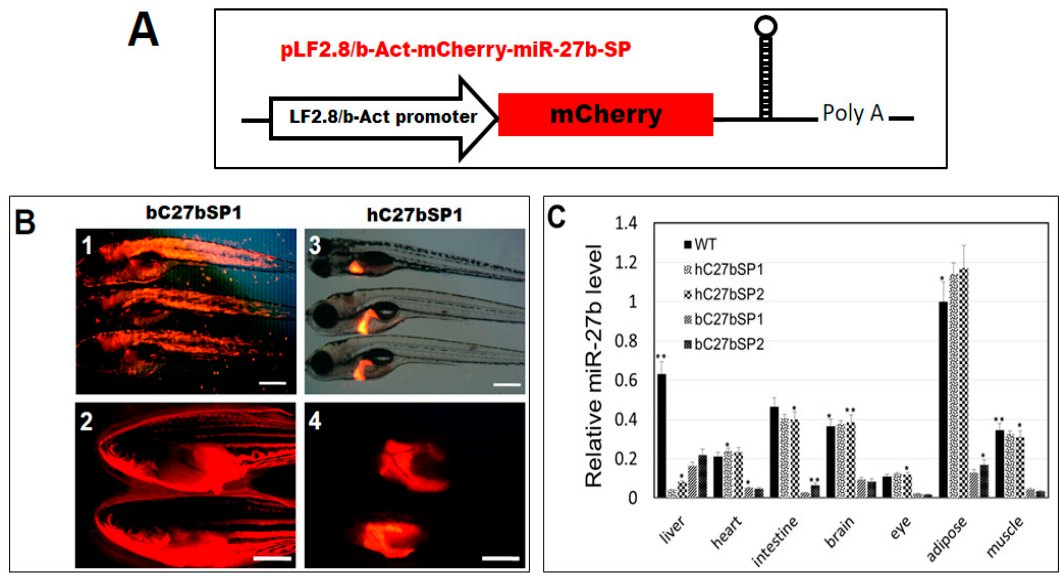
Figure 2. Generation of miR27b-SP transgenic zebrafish. ( A ) Cloning of pri-miR-27b and miR27b-SP into LF2.8 or b-Act expression vectors. ( B ) Red fluorescent images of miR27b-SP expression in the entire body of bC27bSP1 (panel 1, 9 dpf, 40× magnification, scale bars: 200 µm; panel 2, 4 months post fertilization (mpf), 40× magnification, scale bars: 100 mm) and the livers of hC27bSP1 (3, 9 dpf; 4, 4 mpf, 40× magnification, scale bars: 100 mm). ( C ) Stem-loop RT-qPCR analysis of mature miR-27b of the liver, heart, intestine, brain, eye, adipose and muscle tissues from the four transgenic lines, bC7aSPs (bC27bSP1,2) and hC7aSPs (hC27bSP1,2). n = 5–8 for each groups. * p < 0.01, and ** p < 0.005.